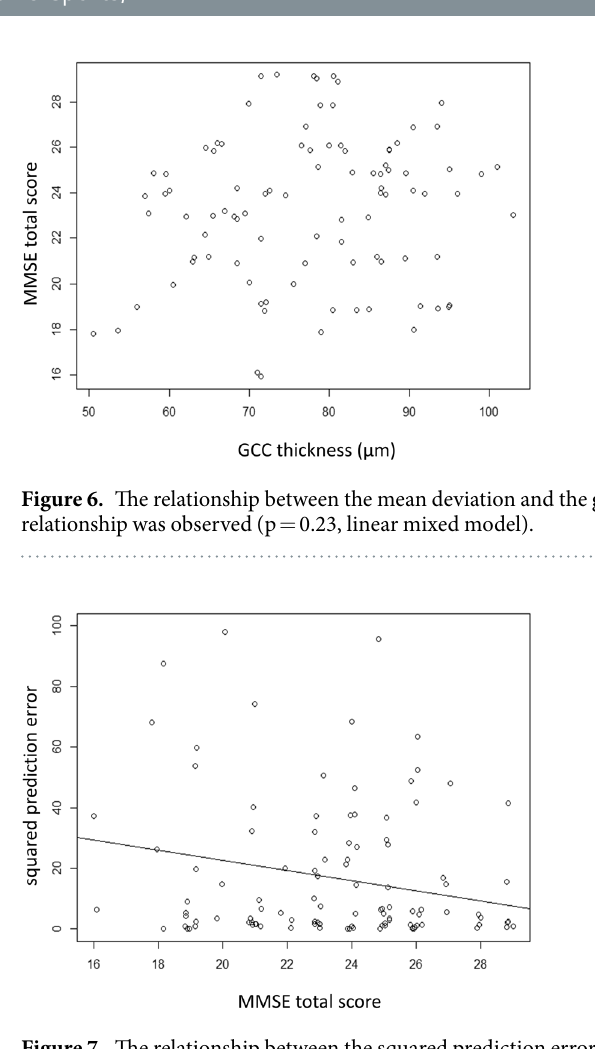
Figure 7. The relationship between the squared prediction error and the Mini Mental State Examination (MMSE) total score. Only the MMSE total score was selected in the optimal model squared prediction error . The squared prediction error = 56.4 − 1.7 (standard error = 0.66, p = 0.0012) × MMSE total